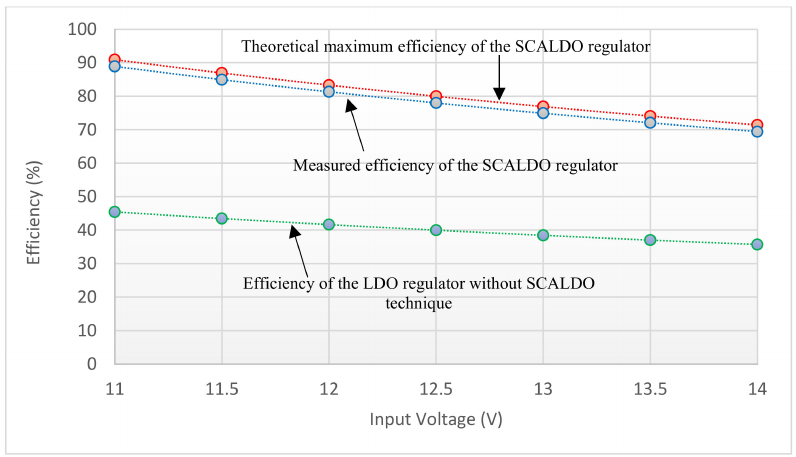
Figure 7. Comparison of the end-to-end efficiencies of the 12–5 V SCALDO regulator and the standalone 5 V LDO regulator against the different supply voltages.